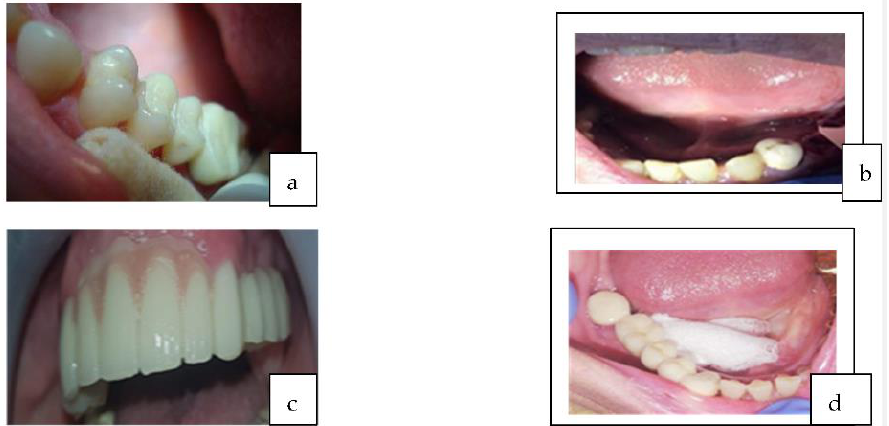
Figure 14. ( a – d ) Rehabilitation treatments through prosthetic modalities by reinforced composite, Poly(methyl methacrylate) (PMMA) composite, unidental and pluridental localization, and ceramic materials pluridental prosthesis.